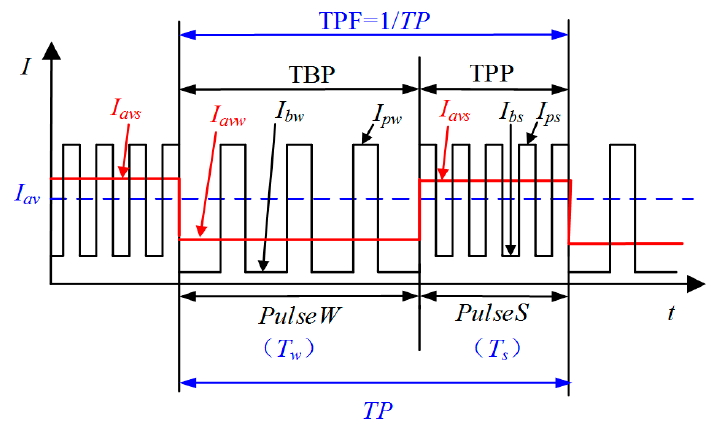
Figure 1. Schematic of the current waveform of the DP-GMAW process.